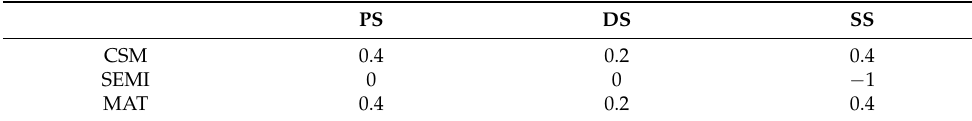
Table 2. Signal weight values.